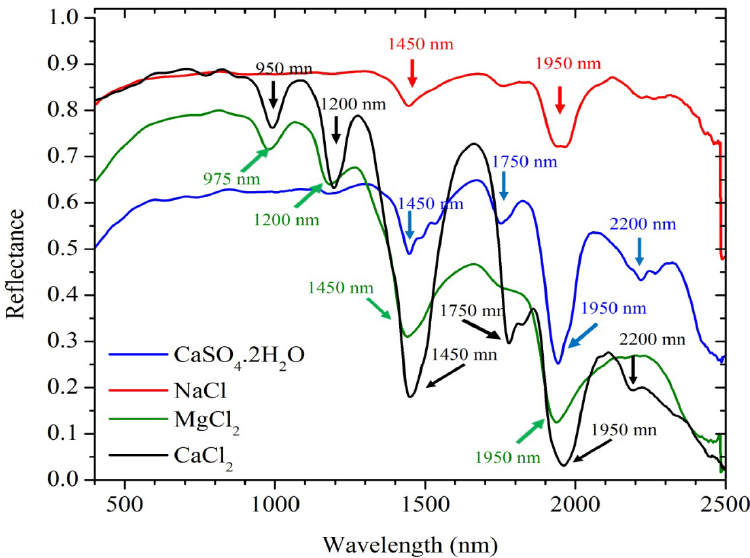
Figure 3. Reflectance spectra of the salts and gypsum used in the experiment. The positions of major absorption features are indicated by arrows.